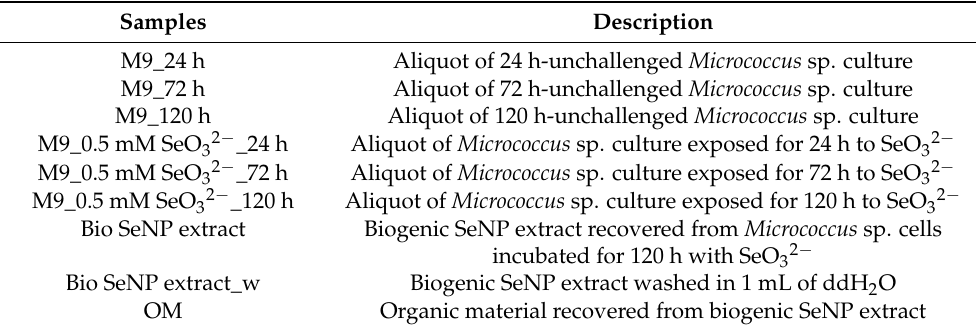
Table 1. Nomenclature and description of the investigated